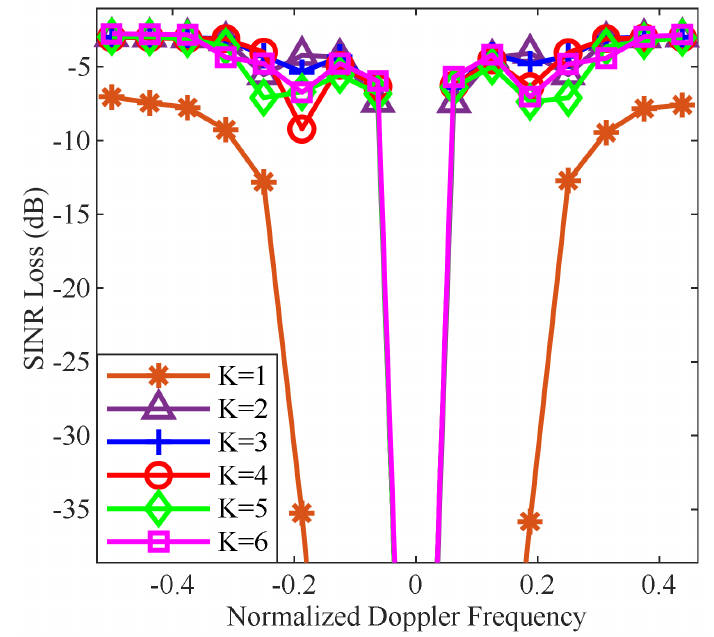
Figure 8. SINR loss comparison of different